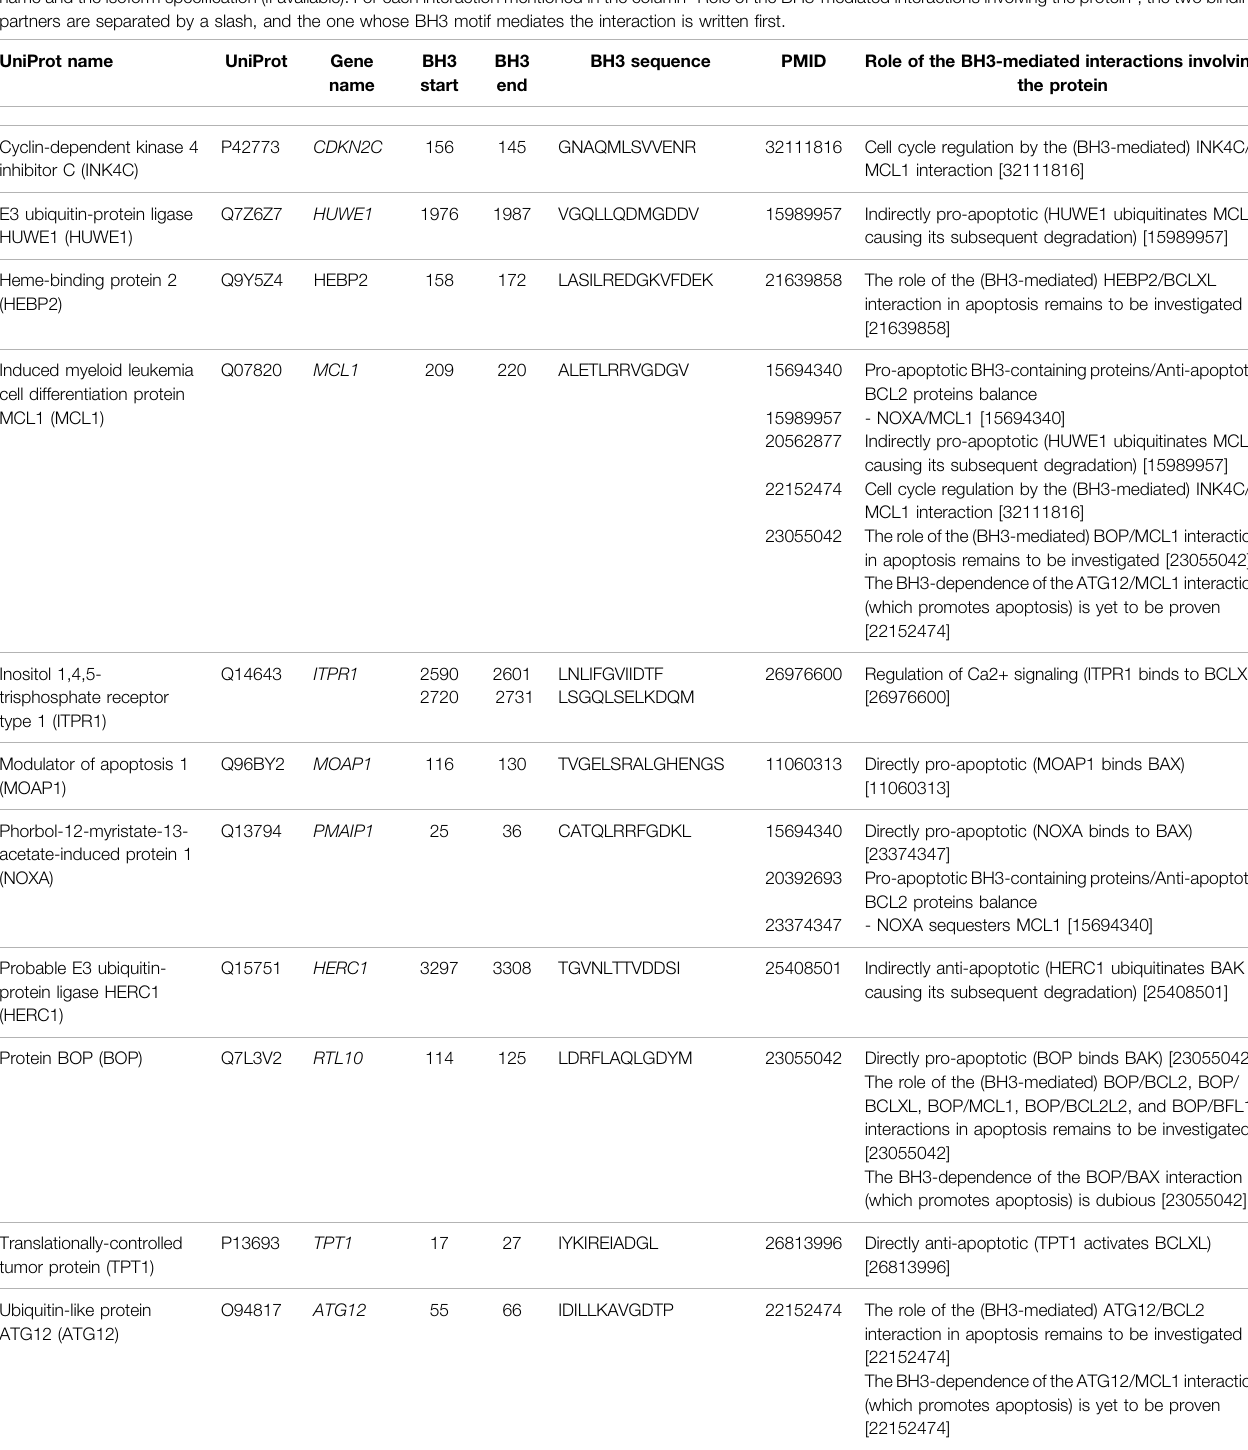
TABLE 1 | ( Continued ) Experimentally validated BH3 motifs from human proteins. We included all members of the BCL2 family (both anti-apoptotic and pro-apoptotic) and BH 3 -containing interactors whose BH3s were reported as not dispensable for binding BCL2 proteins through deletion of the motif or mutations in the critical hotspots. The “ PMIDs ” columncontainsthePubMedIDsofthepublicationswhereBH3-mediatedinteractionsinvolving theproteinsofinterestweredescribedorwherethefunctionalroleof such interactions was investigated (or both). The protein identi fi ers used throughout the text and in the fi gures are reported in parentheses in the fi rst column, after the UniProt name and the isoform speci fi cation (if available). For each interaction mentioned in the column “ Role of the BH3-mediated interactions involving the protein ” , the two binding partners are separated by a slash, and the one whose BH3 motif mediates the interaction is written fi